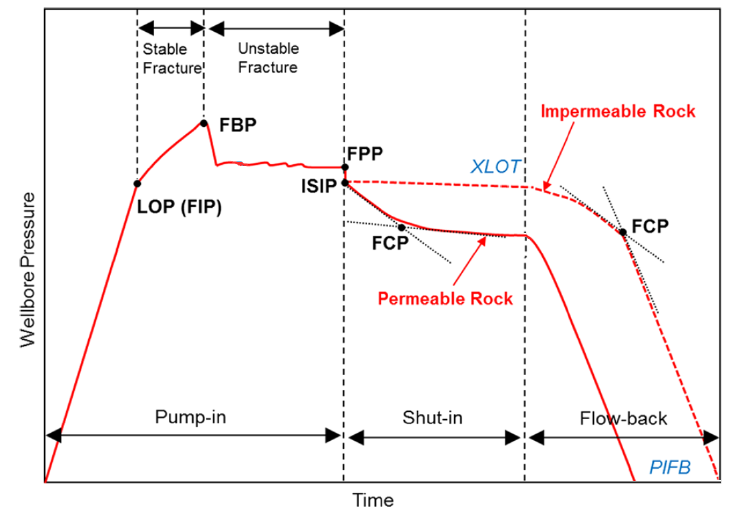
Figure 1. Typical pressure–time response of XLOT